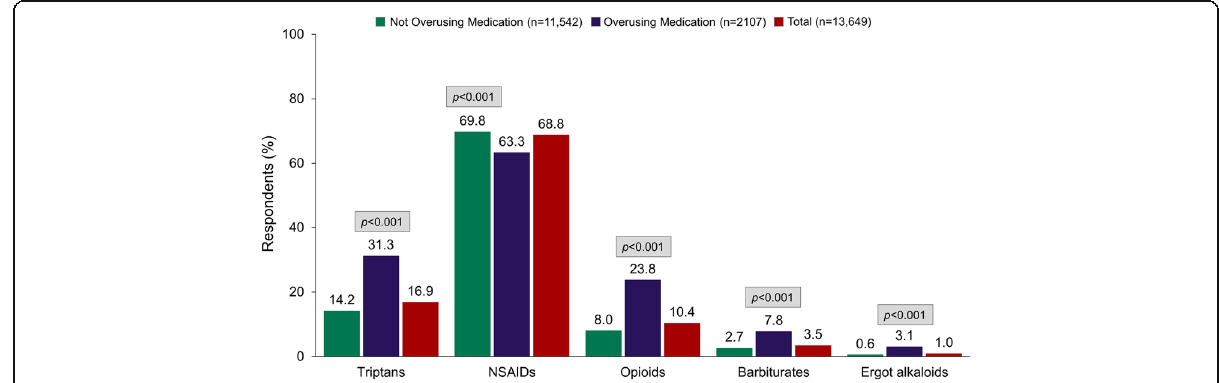
Fig. 1 Medication Overuse by Drug Class Among Respondents with Migraine Currently Using Acute Medication for Headache. Legend: NSAID, nonsteroidal anti-inflammatory drug